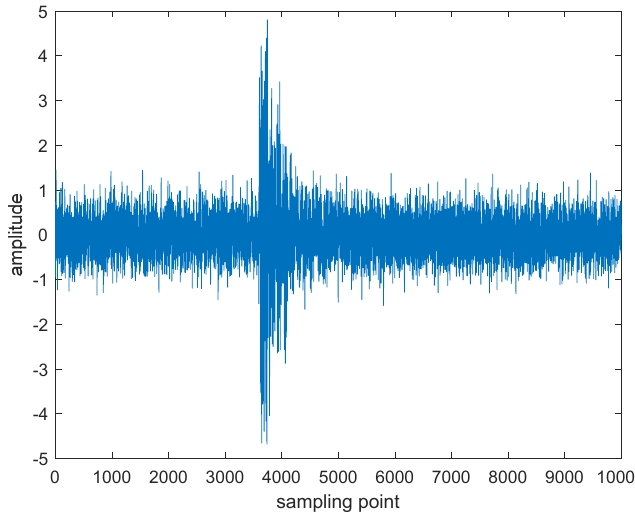
Figure 16. Measured PD signal.